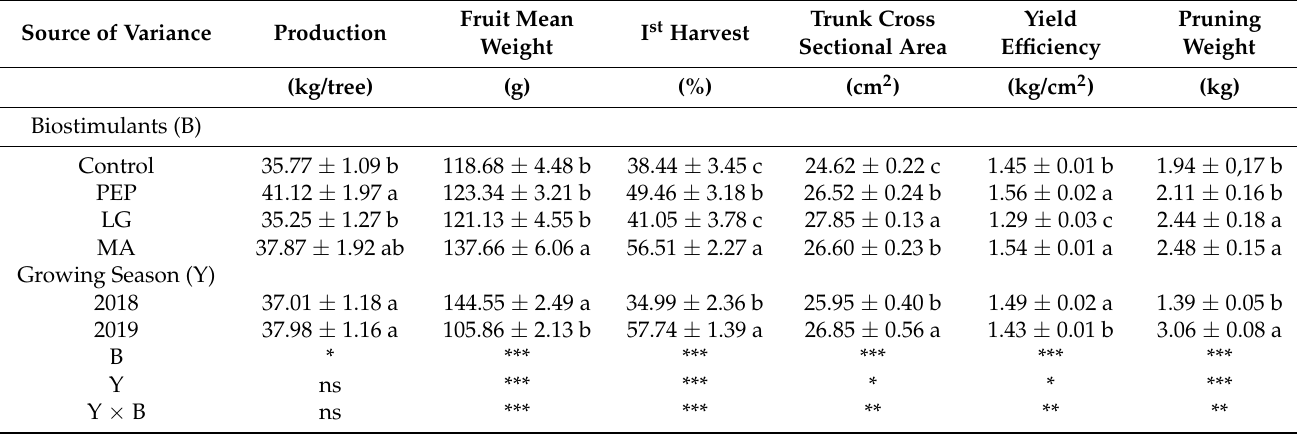
Table 1. Effect of biostimulants LG (seaweed mix + zinc + potassium), PEP (protein hydrolysates), and MA (microalgae) on production, fruit mean weight, I st harvest percentage, trunk cross sectional area, yield efficiency, and pruning